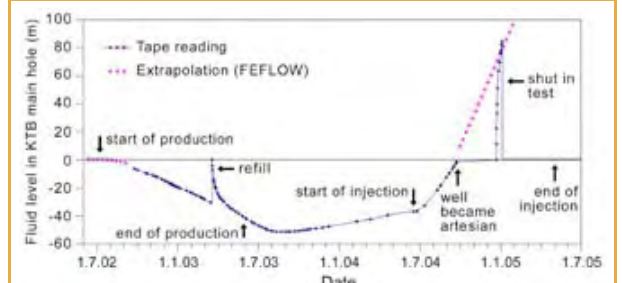
Figure 4. Change of fluid level in KTB-HB in response to hydraulic tests in KTB-VB. FEFLOW-simulation of level change by Kessels, Kuhlmann and Li (personal